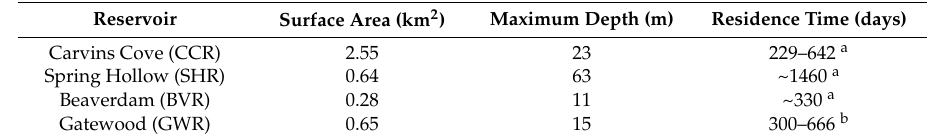
Table 1. Physical and morphometric characteristics of the four reservoir study sites. Superscript letters denote references for the residence time